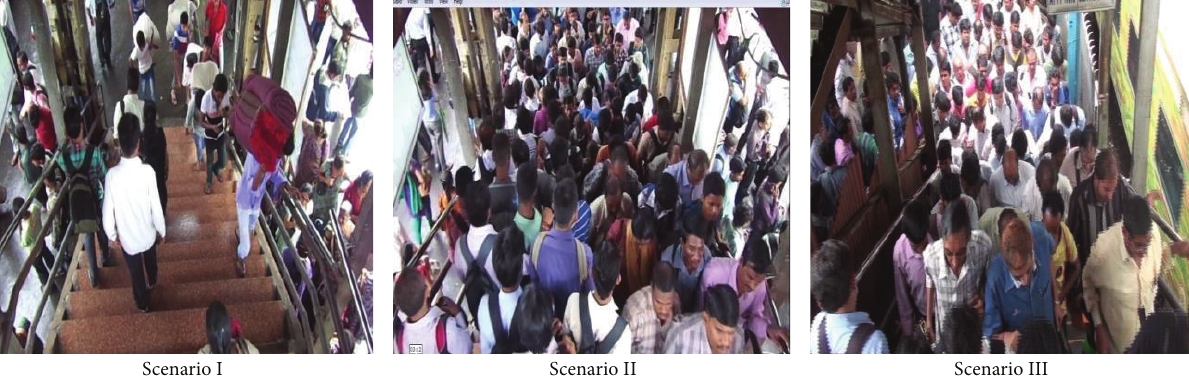
Figure 9: Image of pedestrian movement for various